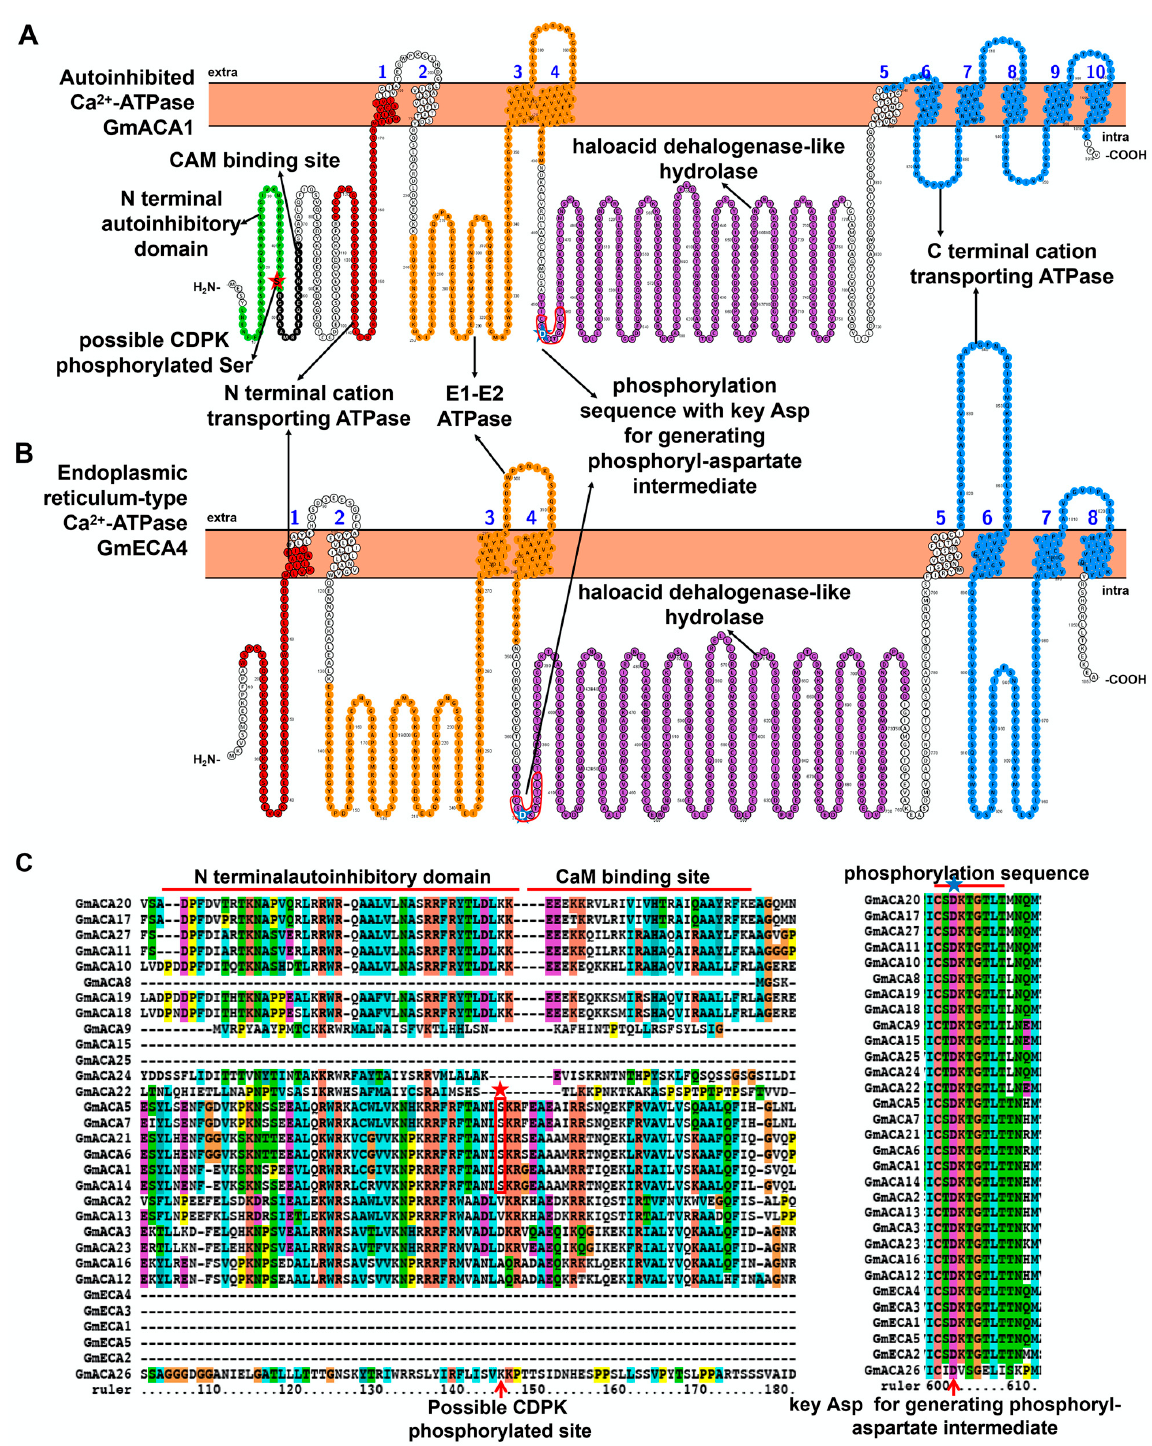
Figure 1. Topology model and homology analysis of soybean Ca 2+ -ATPase, including autoinhibited Ca 2+ -ATPase (ACA) ( A ) and endoplasmic reticulum-type Ca 2+ -ATPase (ECA) ( B ). ( C ) Partial protein sequences alignment of GmACA and GmECA. The red arrows indicate key residues of GmACA and GmECA. The red box in the topology model represents the conserved phosphorylation sequence in the protein sequence alignment. The red star indicates possible CDPK phosphorylated Ser, and the blue star indicates the conserved Asp in the phosphorylation sequence. These protein topology figures were constructed by using Protter [25]. The protein sequences were aligned by using ClustalX1.83 (http://www.clustal.org/download/, accessed on 17 October